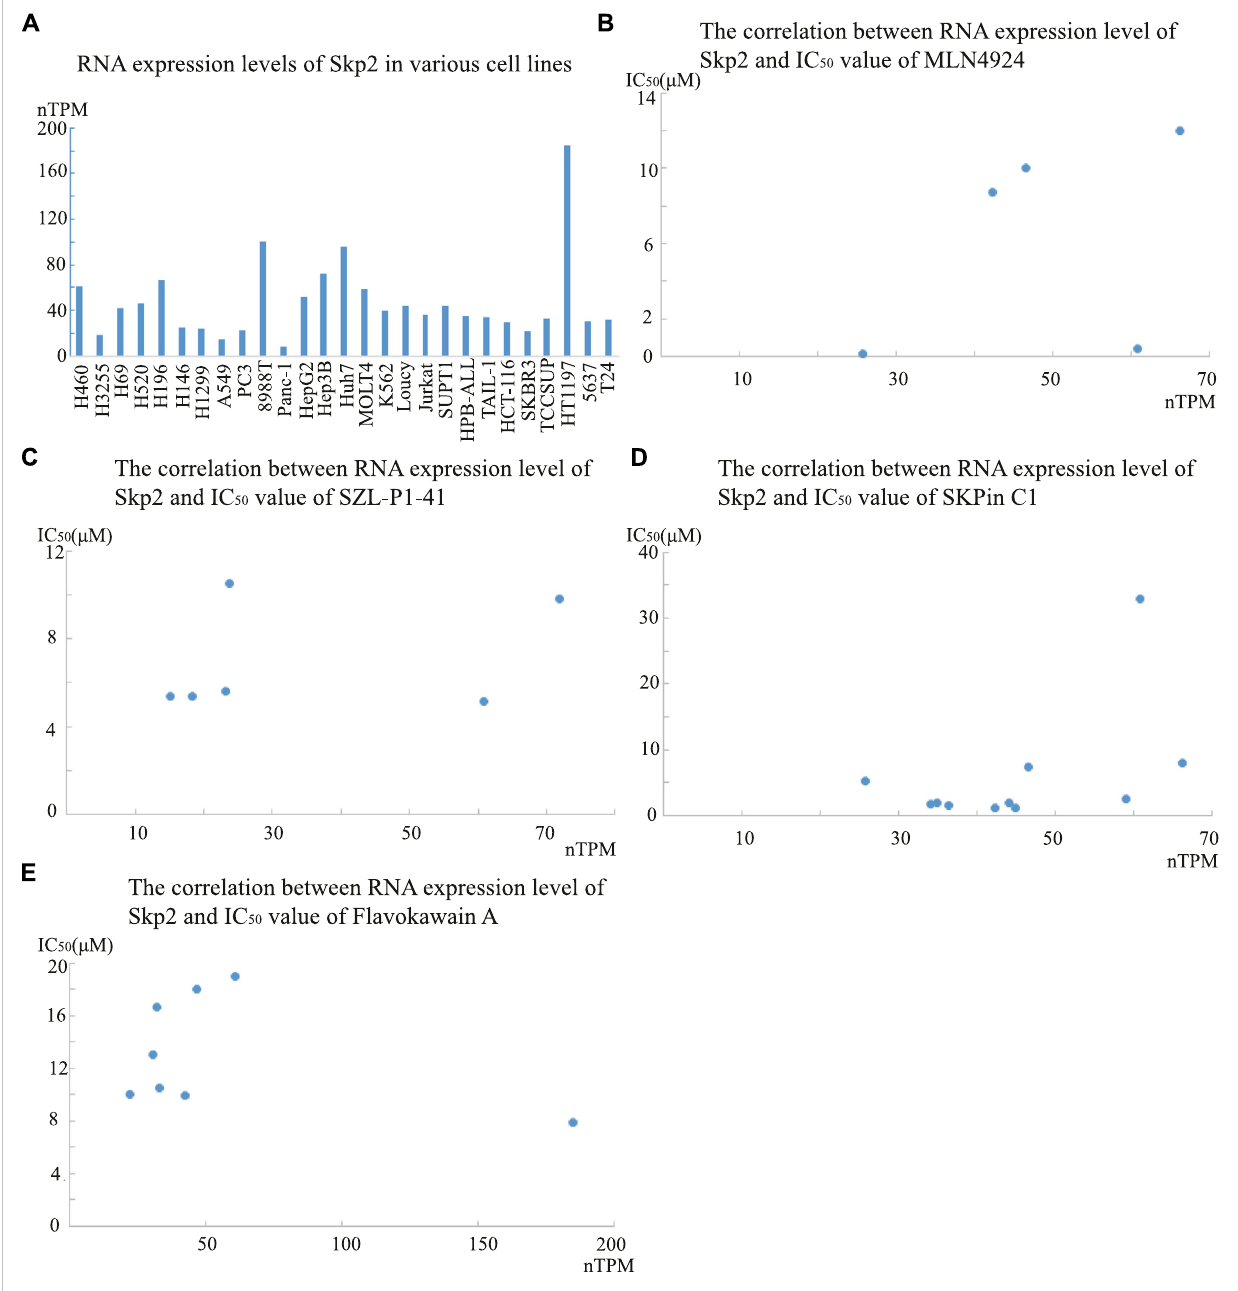
FIGURE 2 The RNAexpressionlevels of Skp2in various cell lines, and its correlation with IC 50 values of fourSkp2inhibiting compounds.A The RNA expression level of Skp2 in various cell lines in Human Protein Atlas database; B-E. The correlation between RNA expression level of Skp2 and IC 50 values of SZL-P1- 41, MLN4924, Skpin C1, and Flavokawain A respectively. The RNA expression level data was collected from Human Protein Atlas database, and the IC 50 value data was collected from the references listed in Table